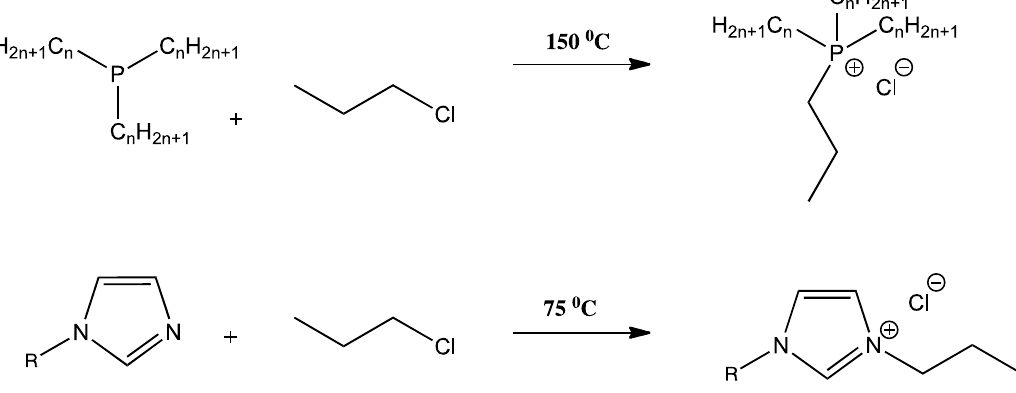
Figure 1. Direct nucleophillic addition of a trialkylphosphine (top) and 1-substituted imidazole (bottom) with 1-chloropropane to form their corresponding chloride Ionic Liquids